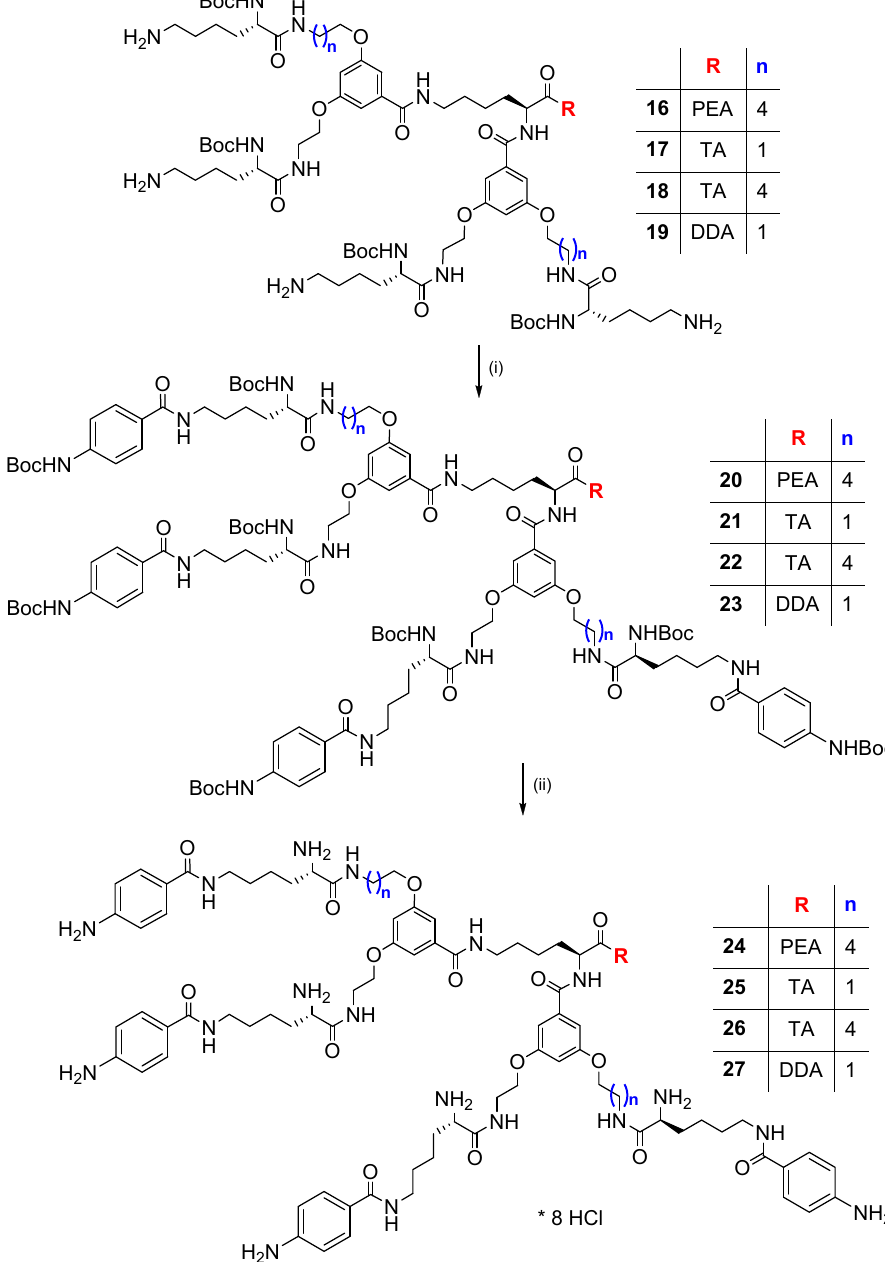
Scheme 4. Synthesis of dendrimers terminated with p -aminobenzoic (PABA) residues (20–23,